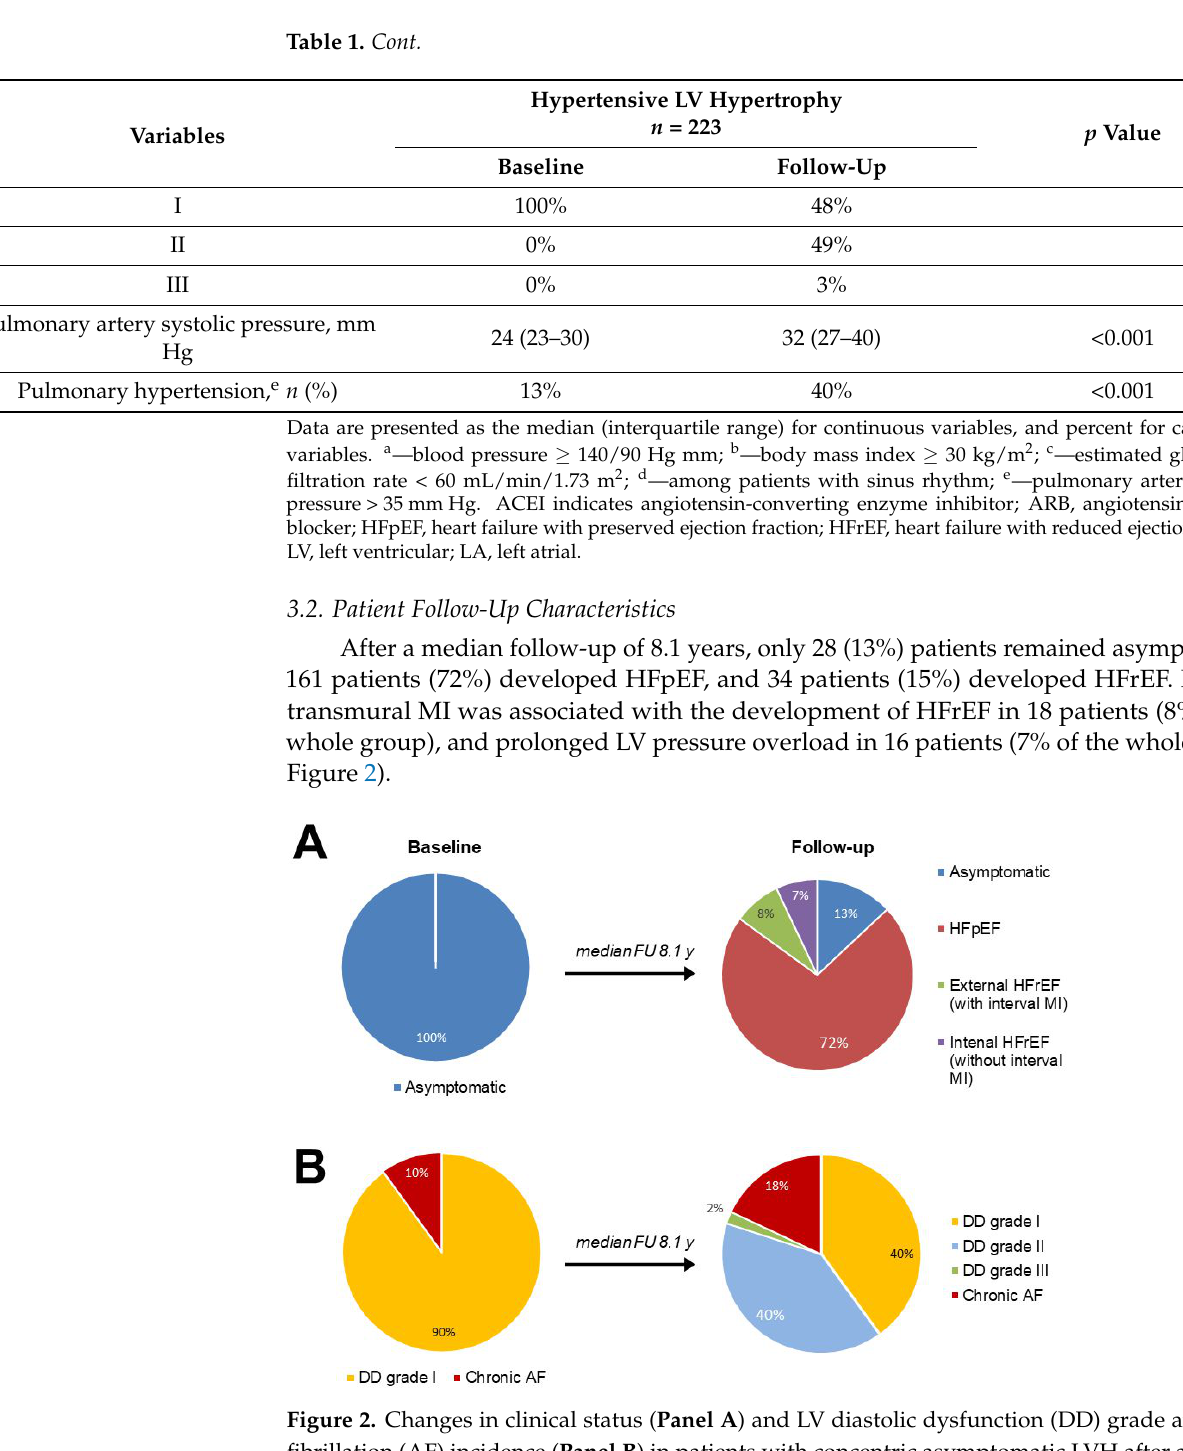
Figure 2. Changes in clinical status ( Panel A ) and LV diastolic dysfunction (DD) grade and atrial fibrillation (AF) incidence ( Panel B ) in patients with concentric asymptomatic LVH after a median follow-up (FU) of 8.1 years.